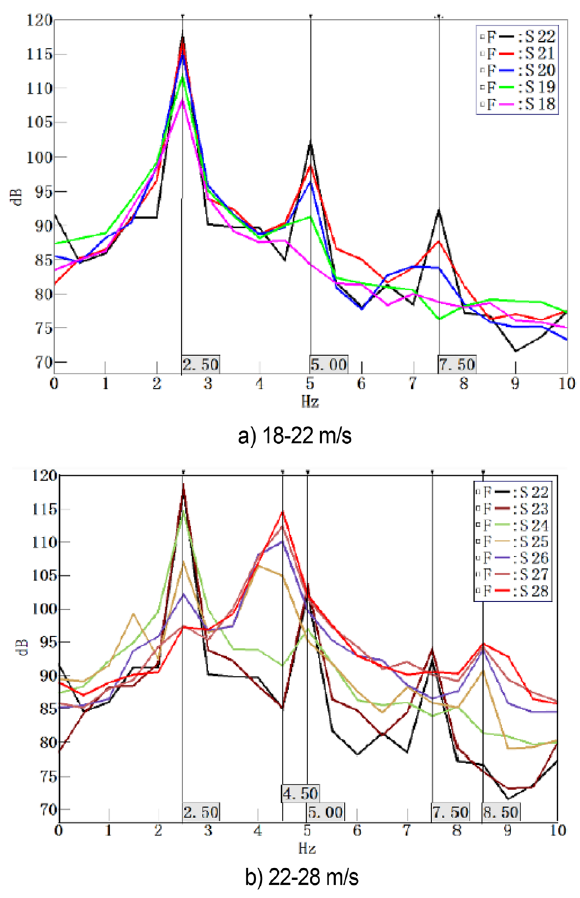
Figure 13. Power Spectrum Density Function at Pulsation Interval